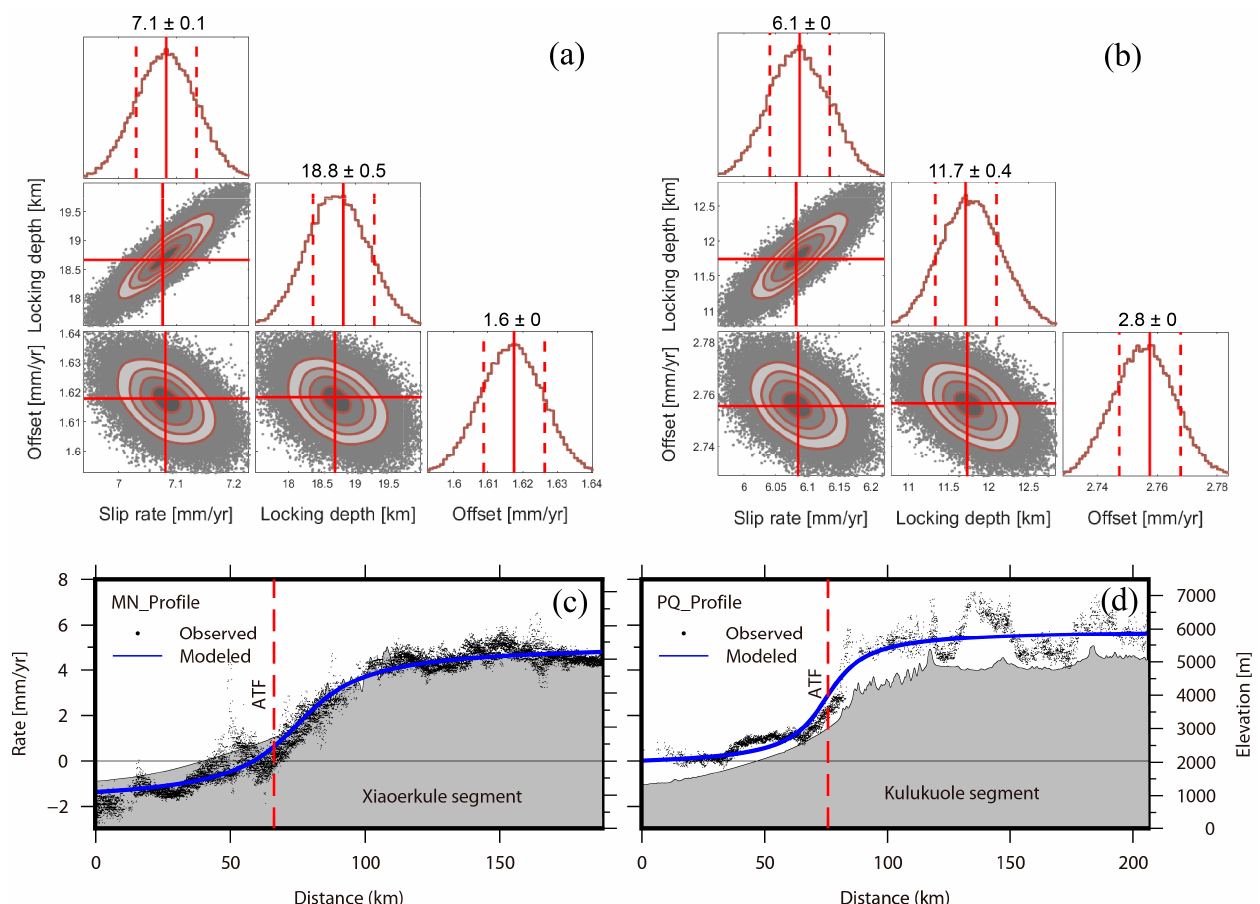
Figure 5. Probability distributions for profiles MN ( a ) and PQ ( b ). The red line and dot indicate the maximum a posteriori probability (MAP) solution from the Markov chain Monte Carlo (MCMC) analysis. We modeled fault-parallel velocity profiles along ATF, ( c ) for profile MN, and ( d ) for profile PQ. The profile’s location is shown in Figure 4. The red dashed lines are the fault location of ATF.